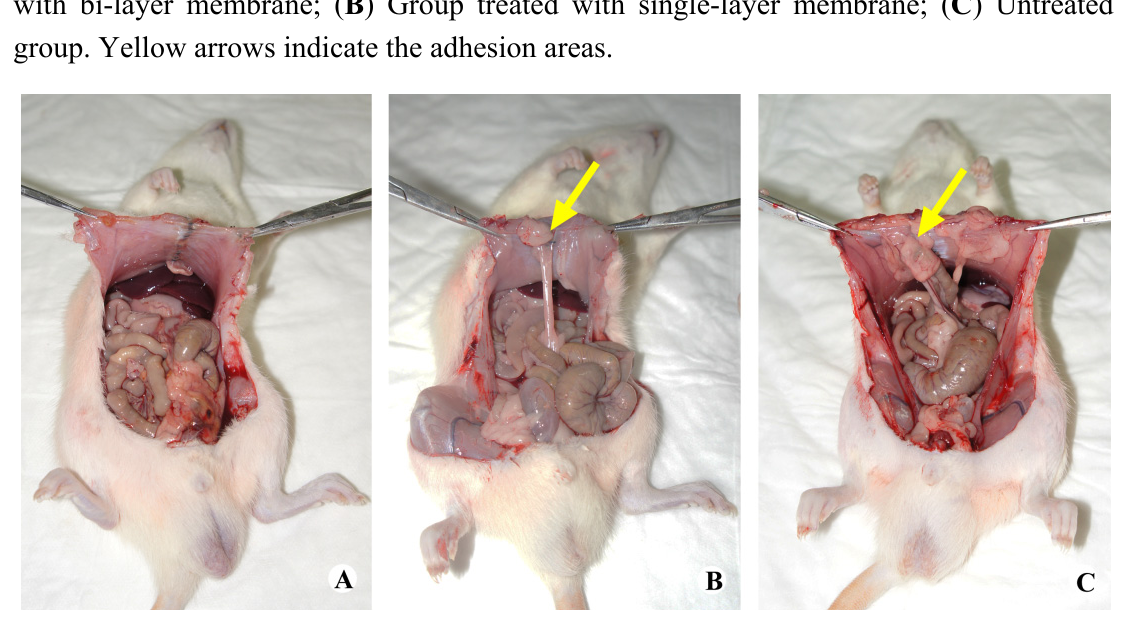
Figure 3. The average scores of intra-abdominal adhesion in the control group, bi-layer membrane group and PCL electrospun fibrous membranes group are presented as mean ± SD ( n = 8).( * p < 0.05 vs .